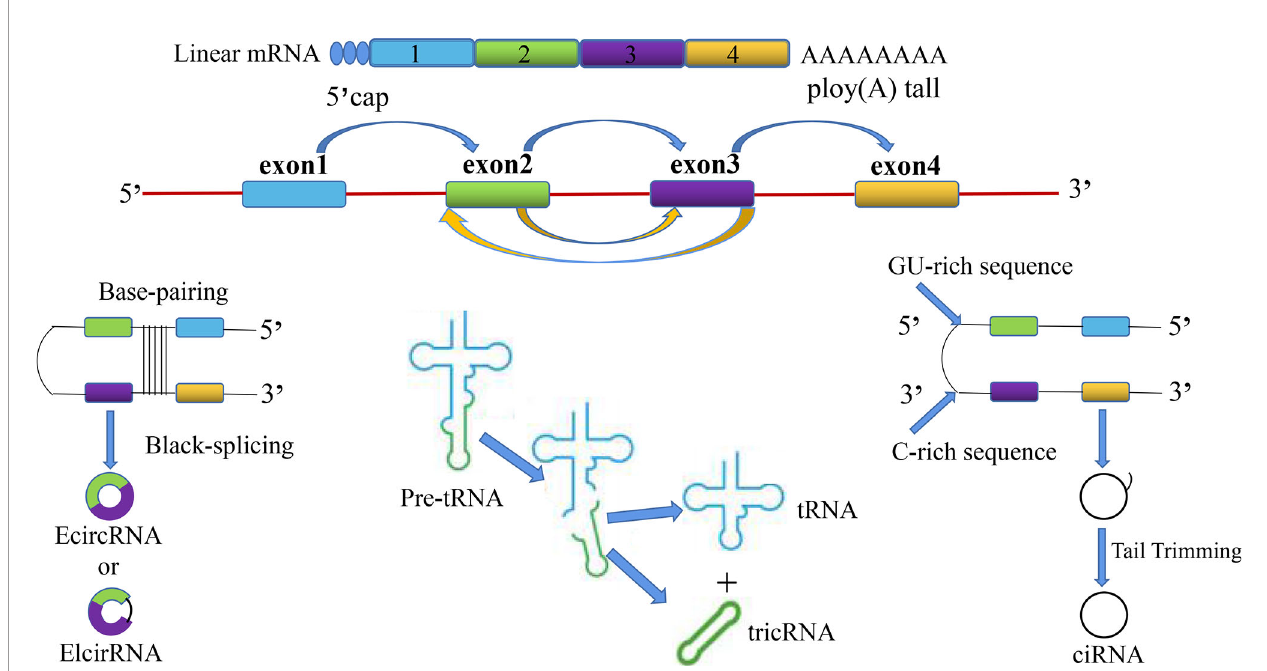
FIGURE 1 | The overview diagram shows four biosynthetic pathways related to the source of circular RNAs: (1) whole-exonic-type circRNAs (EcircRNA); (2) circRNAs with introns and exons (EIcirRNA); (3) lasso-type circRNAs composed of introns (ciRNA); and (4) circRNAs produced by cyclization of viral RNA genomes, ribosomal RNAs, small-nuclear RNAs, and transfer RNAs